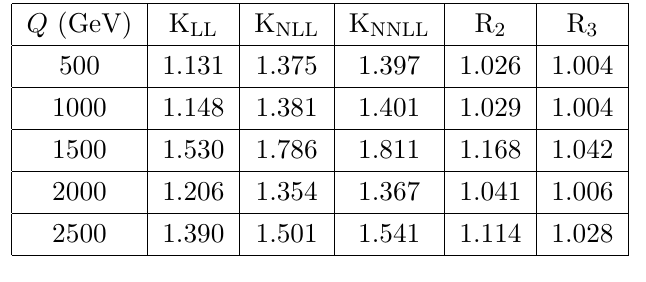
Table 4 . Resum K-factors and the ratios as de(cid:12)ned in eq. (3.3) and eq. (3.4) as a function of the di-lepton invariant mass for the default choice of RS model